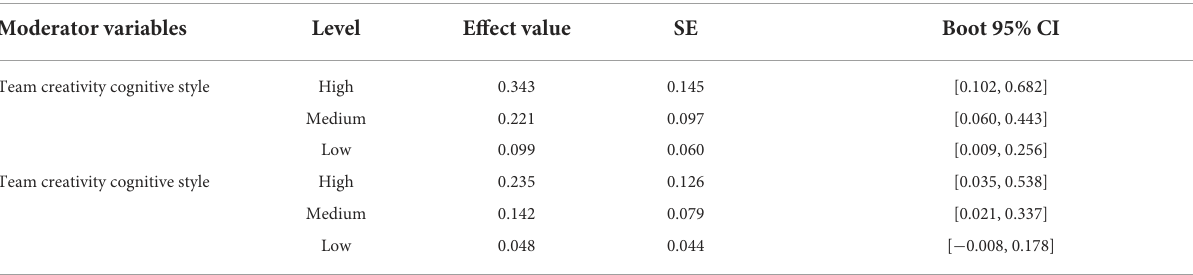
TABLE 4 Conditional indirect